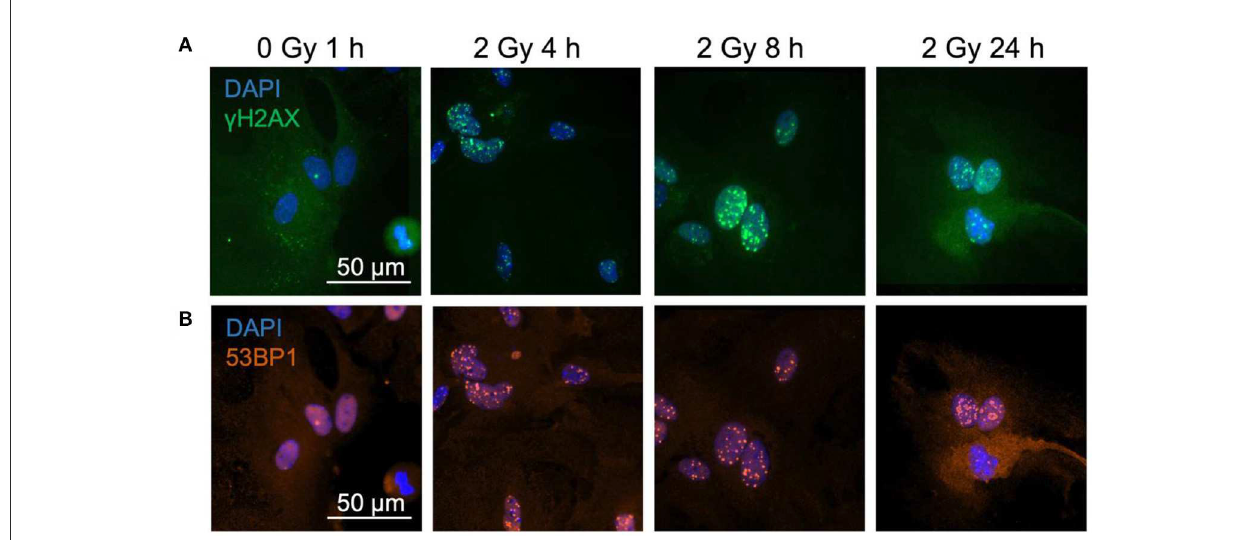
FIGURE1 γ H2AX and 53BP1 foci form in astrocytes’ nuclei after exposure to iron ions. Astrocytes were mock-irradiated (0Gy) or irradiated with 2Gy of 56 Fe ions and fixed at different time points for immunofluorescence staining of the DNA double strand marker γ H2AX and the DNA repair protein 53BP1. 53BP1 as a marker protein expressed mainly during non-homologous end-joining (NHEJ) was assessed as indicator of DNA repair pathway choice. Cell nuclei were stained with DAPI (blue) for all images. (A) Exemplary images of γ H2AX (green) immunostaining of astrocytes. Scale bar: 50 µ m. (B) Exemplary images of 53BP1 (red) immunostaining. Bar: 50 µ m.